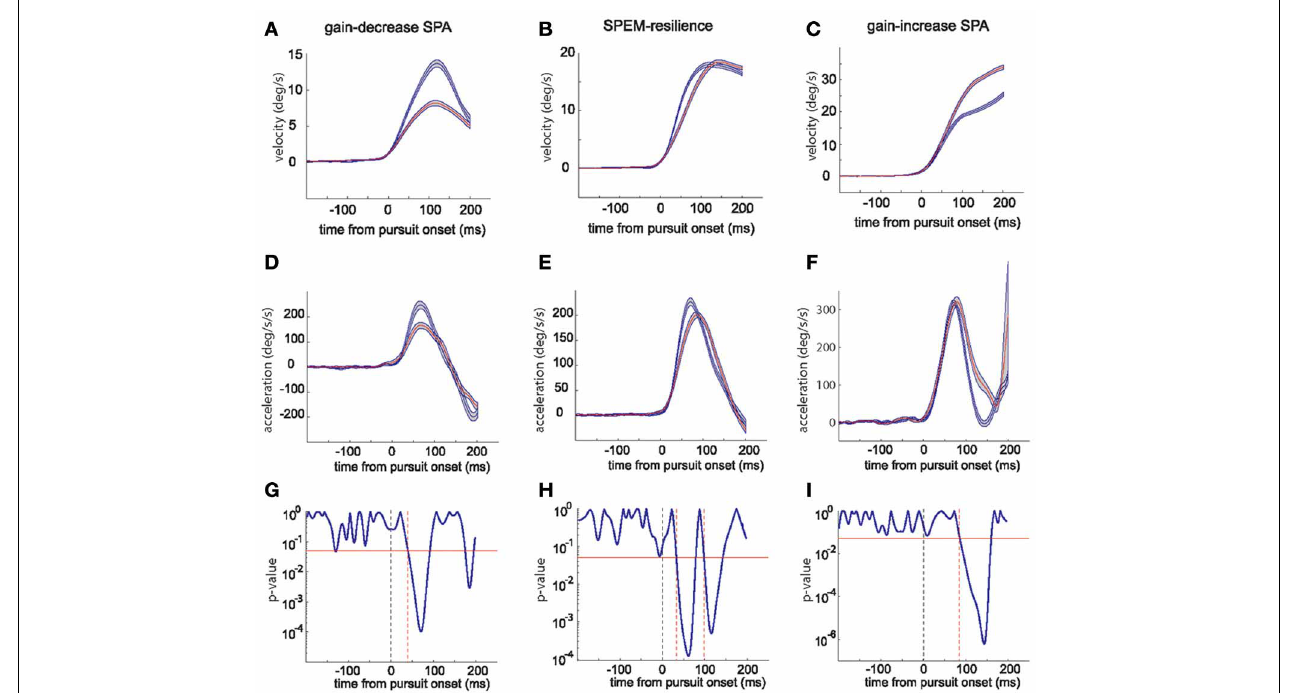
FIGURE 2 | The top row panels show the average eye velocity in the first quarter (blue) and last quarter (red) of trials during a typical gain-decrease SPA session (A), SPEM resilience session (B) and gain-increase SPA session (C). The middle row panels (D–F) depict the corresponding average eye acceleration traces. The gray shadow around the red and blue traces signifies the standard error.